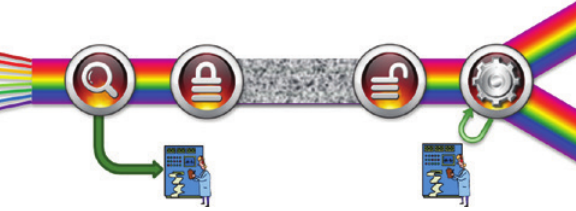
Figure 1: Use cases for digital optical